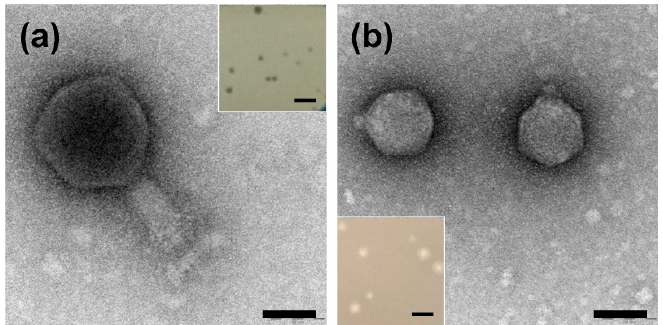
Figure 1. Characteristics of the virions and plaques of the vB_OspM_OC ( a ) and vB_OspP_OH ( b ) phages. The scale bars in the transmission electron microscopy (TEM) images represent 50 nm. The phage plaques are presented in the insets on panel ( a ) (plaques of vB_OspM_OC) and ( b ) (plaques of vB_OspP_OH). The scale bars in the insets represent 1 mm.